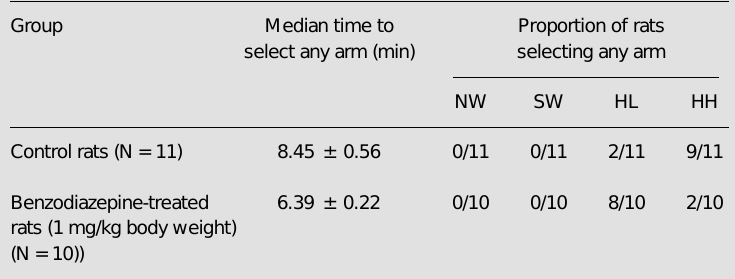
Table 2 - APM arm preference test in animals treated with distilled water or diazepam at the dose of 1 mg/kg body weight. Results are reported as the median ± SEM. For abbreviations see legend to Table